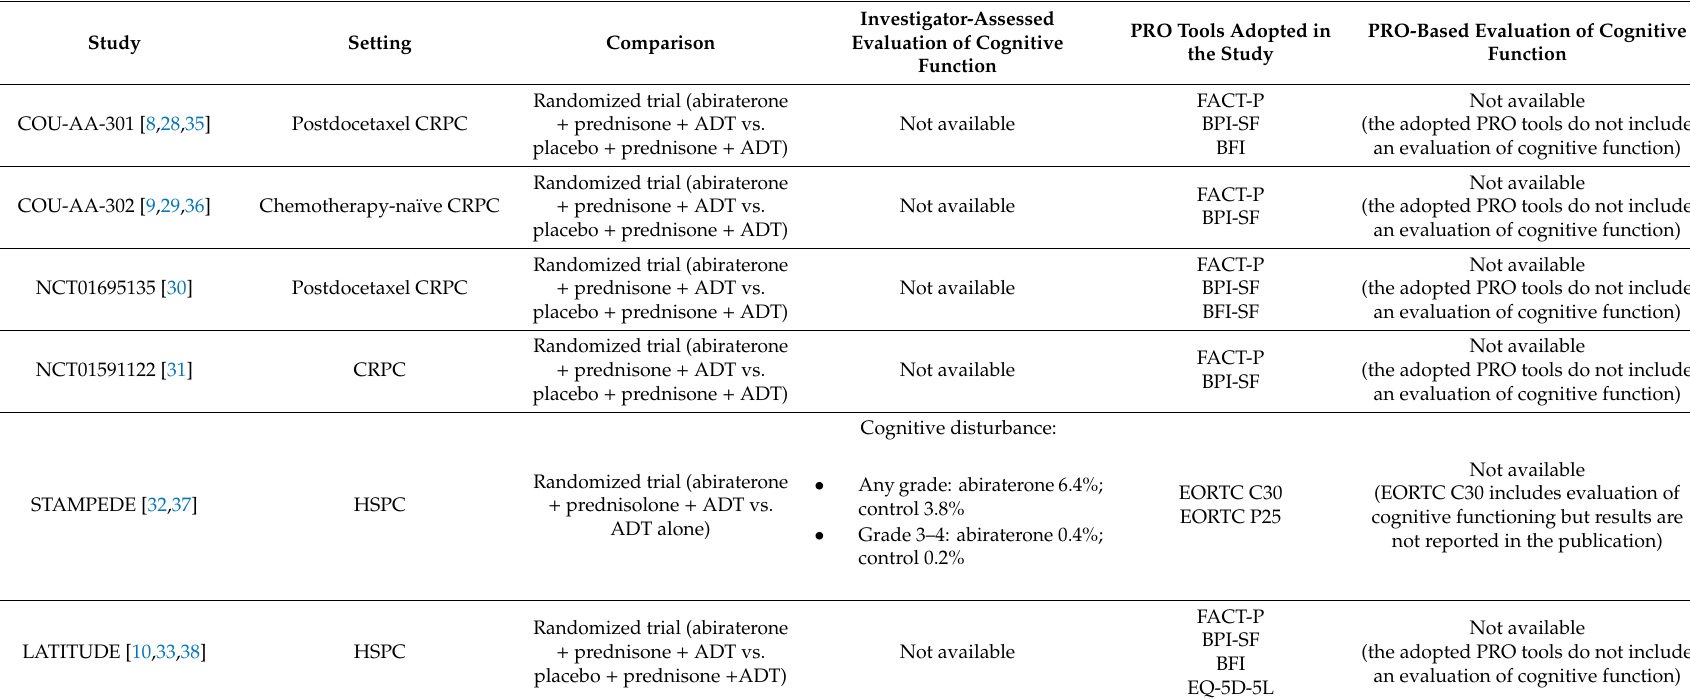
Table 1. Trials testing